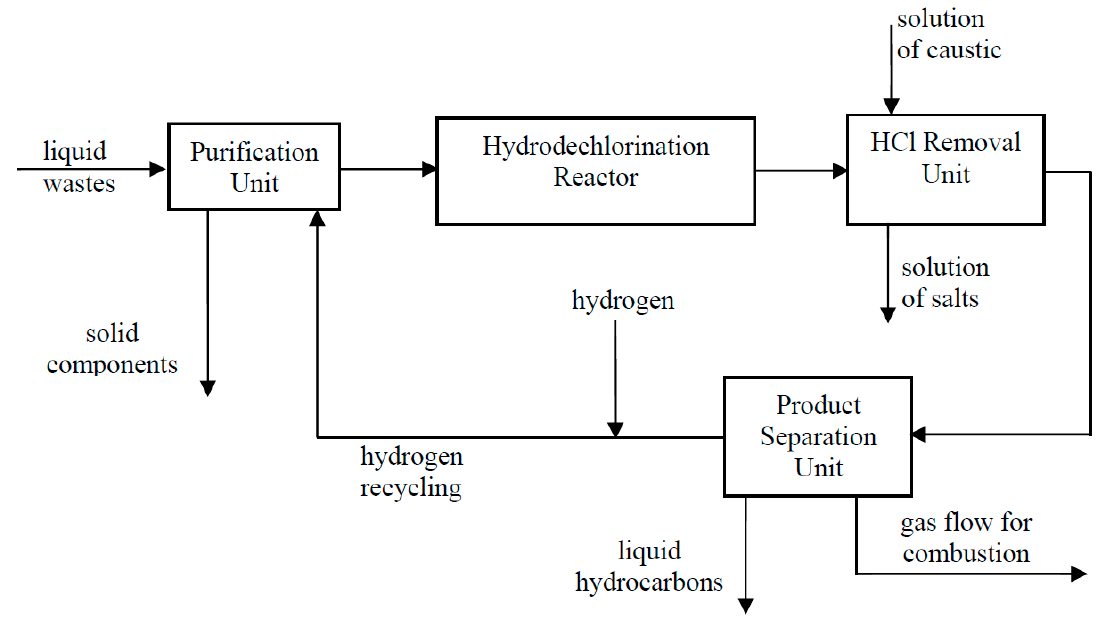
Figure 7. Flow-chart of waste hydrodechlorination with fuel obtaining.